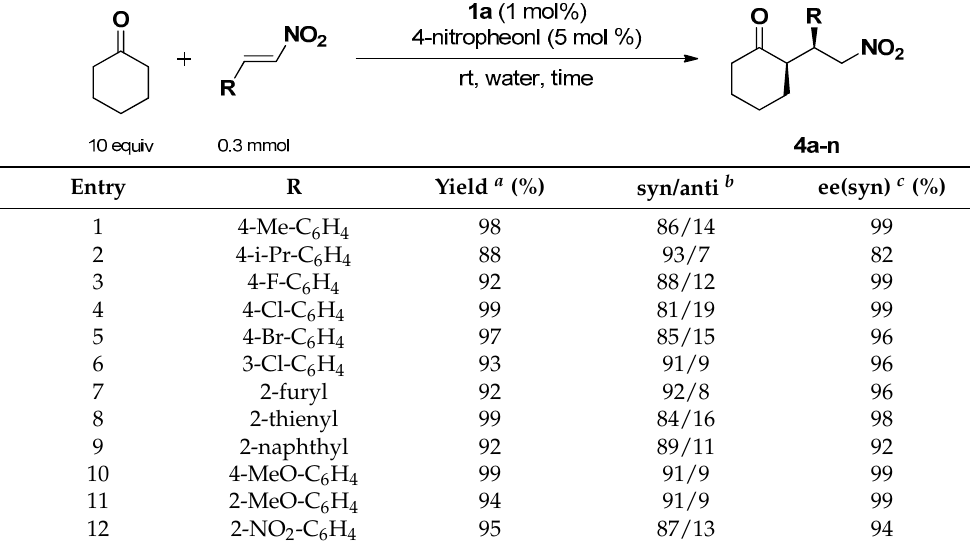
Table 3. Asymmetric Michael reaction of the cycloketones and various α , β -unsaturated nitroalkenes using the thiourea catalyst.